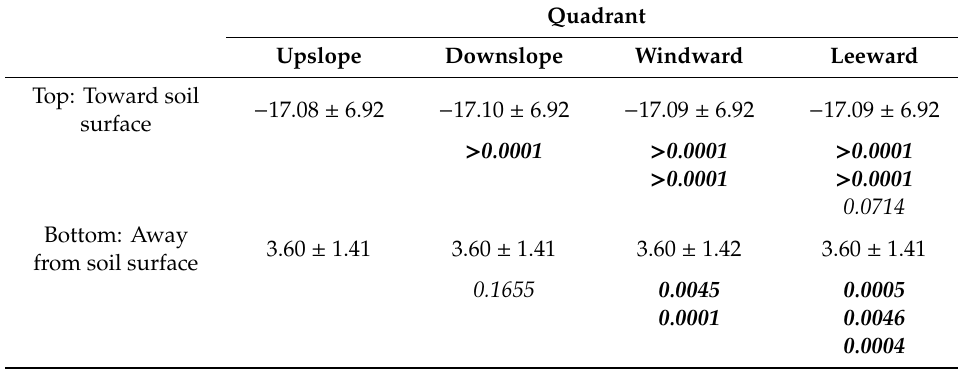
Table 2. Values of compression (blue colors in Figure 7) and tension forces (red colors in Figure 7) acting on the four theoretical lateral roots extending in the four di ff erent 3D quadrants. Mean ± standard deviation of the mechanical force (MPa) distribution obtained by the model along the lateral root axis (0–60 cm). The di ff erences in force intensity values measured in the upper (compression forces—blue colors) and lower side (tension forces—red colors) of each lateral root extending in the four 3D quadrants (upslope, downslope, windward, and leeward) are presented. P values are indicated in italic, and in bold only when indicate significant di ff erences ( p <